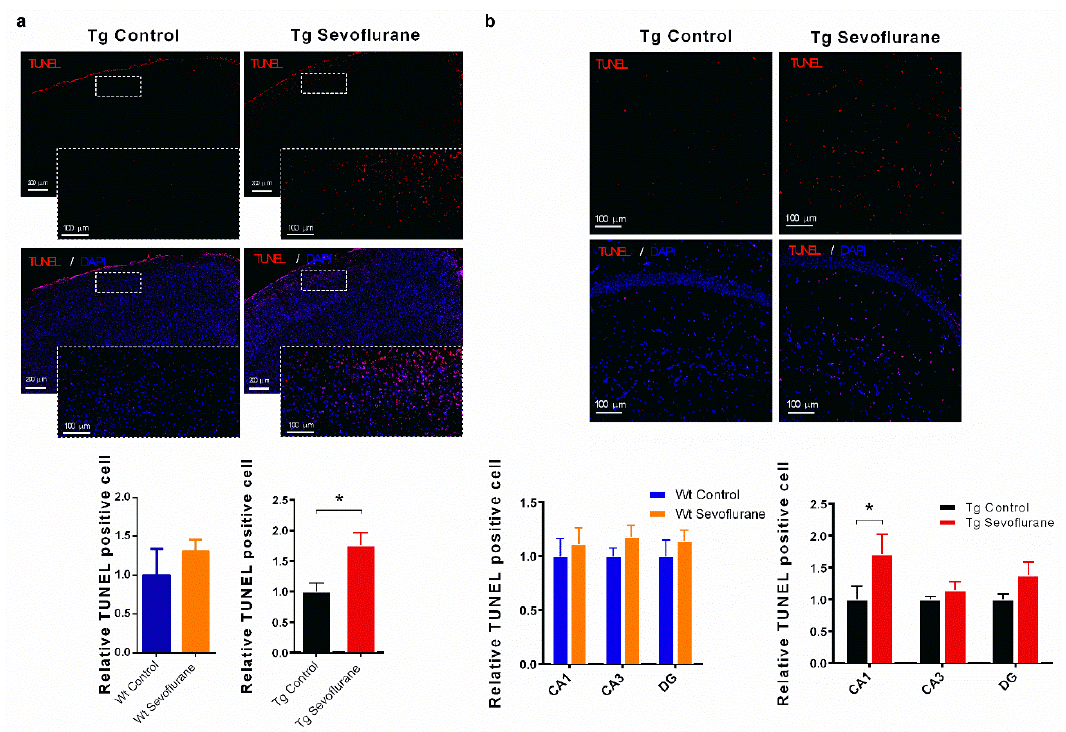
Figure 6. DNA damage in 3 × Tg mice brain after sevoflurane exposure but not in wild-type mice . TUNEL staining indicated the DNA fragmentation in the ( a ) neocortex and ( b ) hippocampus of 3 × Tg mice. A significant increase in TUNEL-positive cells was found in 3 × Tg mice but not in wild-type mice ( a , b ). Statistic graphs show the quantification of immunofluorescence intensities in the images. Data correspond to the mean ± SEM ( n = 4). * p < 0.05 in comparison to the control. Values were analyzed using the unpaired t -test.